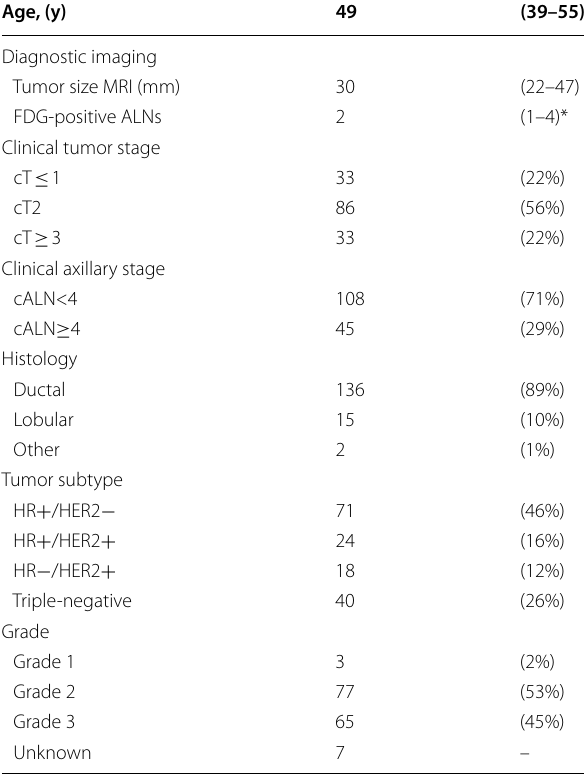
Table 1 Baseline patient characteristics ( N